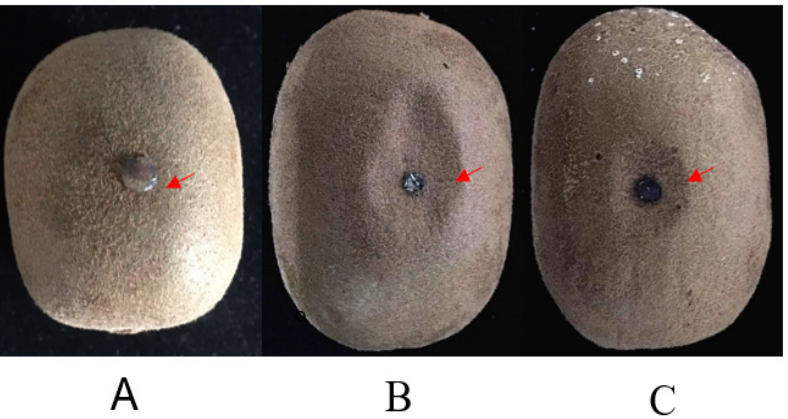
Figure 4. Symptoms of kiwifruit inoculated by Botryosphaeria dothidea . ( A ) No external symptom (arrow) of kiwifruit artificial infection with fungi-free PDA. ( B ) External slightly sunken symptom (arrow) of kiwifruit artificial infection with B. dothidea (Bd 431 comes from the diseased fruit). ( C ) External slightly sunken symptom (arrow) of kiwifruit artificial infection with B. dothidea (Bd432 comes from the wart).